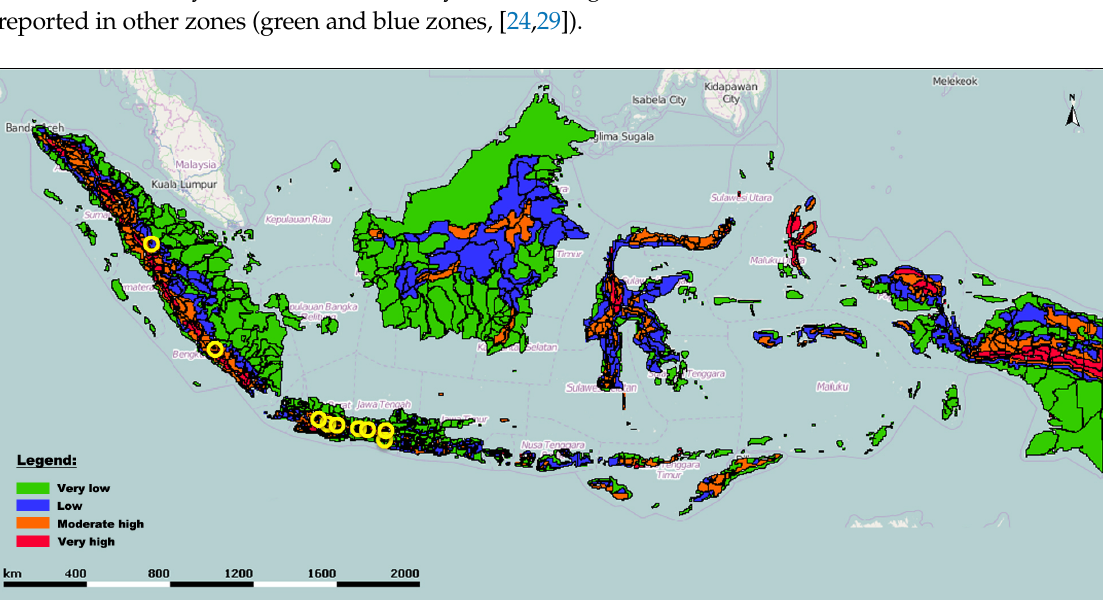
Figure 3. Map of landslide-prone areas across Indonesia. Yellow circles indicate the locations where the soil samples were